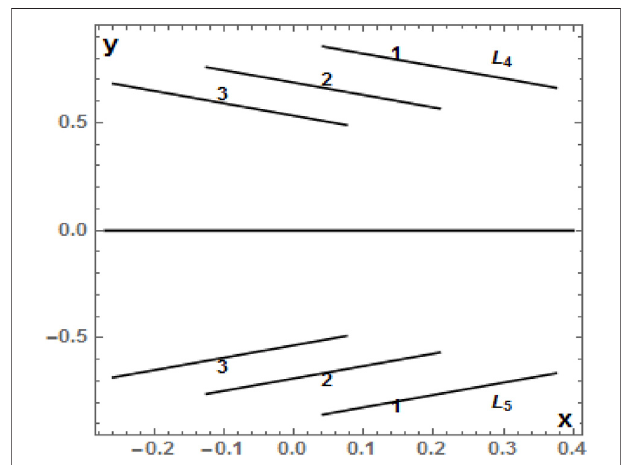
FIGURE 6 | Positions of the two triangular equilibrium points L 4 and L 5 on the xy – plane as a function of q 2 , which varies in the interval (0, 1] for fi xed values of q 1 equal to 1 (1), 0.5 (2), and 0.1 (3). The disc, oblateness, and triaxiality parameters are kept as constants as given in Table 3